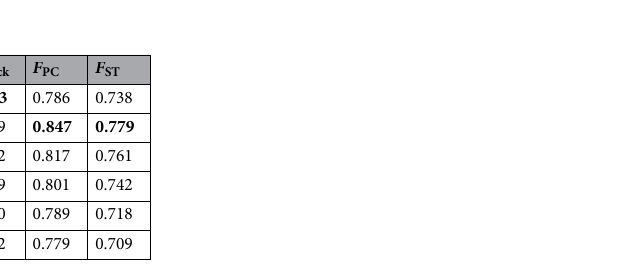
Table 5. Comparison of F 1 scores with the top five models in CPSC2018. Significant values are in bold.